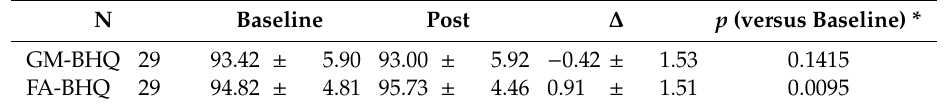
Table 2. Changes in the brain healthcare quotient scores based on gray matter volume and fractional anisotropy. N